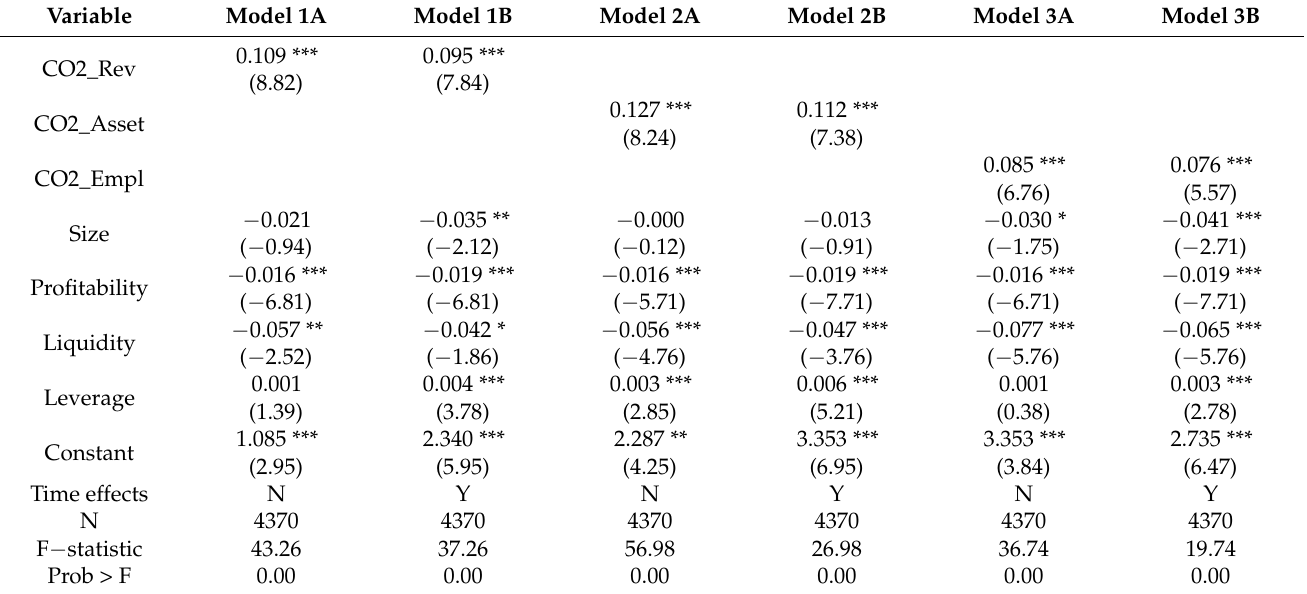
Table 4. The estimation results of basic regression